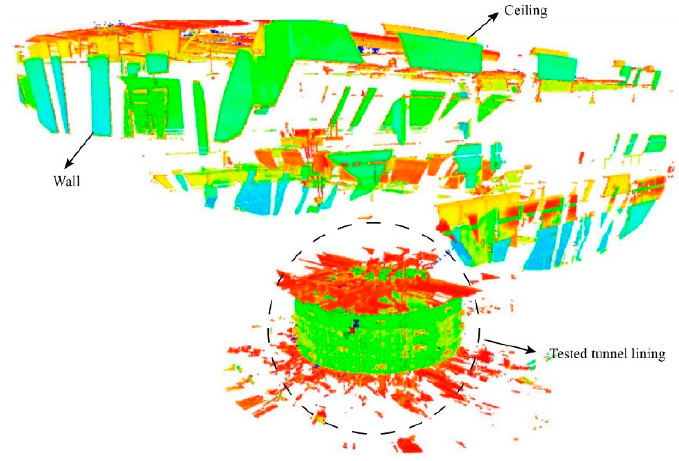
Figure 3. Raw laser scanning data of the site of a loading test on the tunnel lining.